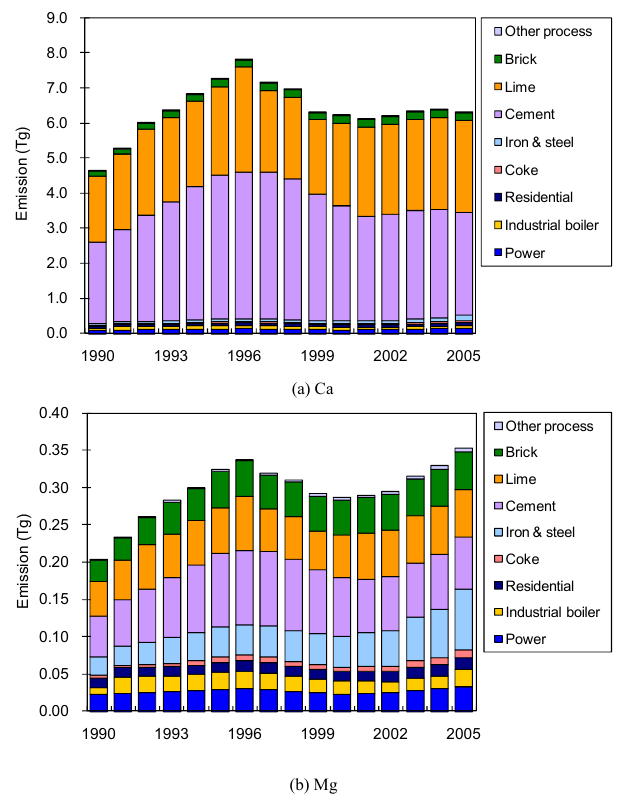
Fig. 9. Emissions of (a) Ca and (b) Mg from 1990 to